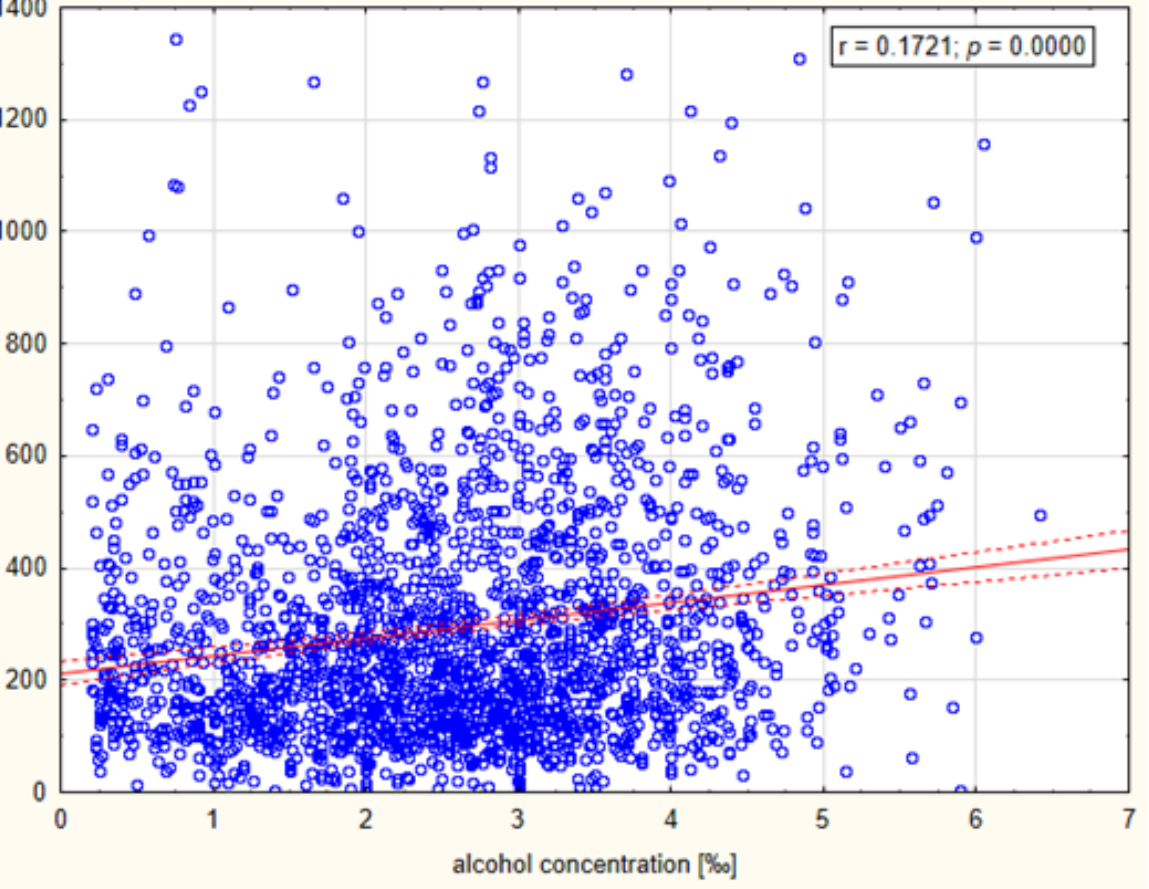
Figure 2. Relationship between patients’ blood alcohol concentration and their length of stay in ED (measured in minutes).